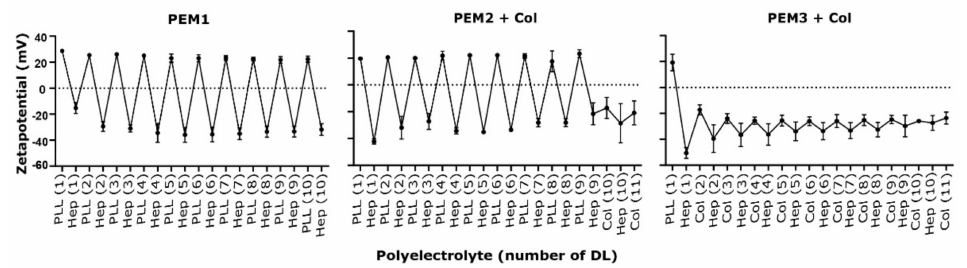
Figure 2. Change of the zeta potential for all three film systems as function of polyelectrolyte layer deposition. For each data point the mean values from three independent experiments are